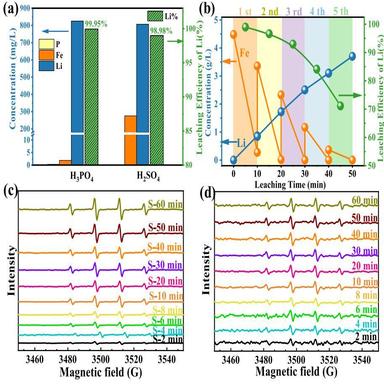
(a) Leaching results for different solutions configured with different acids at pH = 2.1; (b) Circulating leaching with solutions configured with sulfuric acid (Cycle condition: slurry density- 20 g/L, 400 mmol/L H2O2 and pH = 2.1 that are controlled by dropwise addition of concentrated sulfuric acid);and EPR spectra for the generation of •OH under different reaction conditions ((c) blank process: 30 mmol/L H2O2 and 0.5 mmol/L FeSO4, (d) reaction process: 1 g/L LiFePO4, 30 mmol/L H2O2, 0.5 mmol/L FeSO4 and